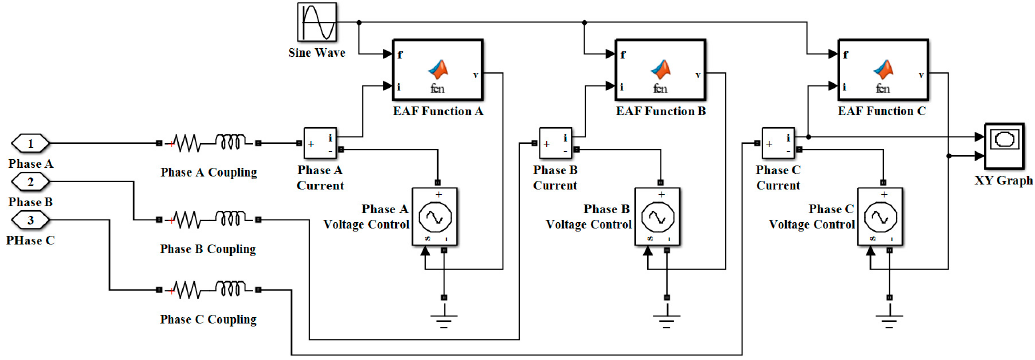
Figure 8. EAF model simulating flicker disturbance.